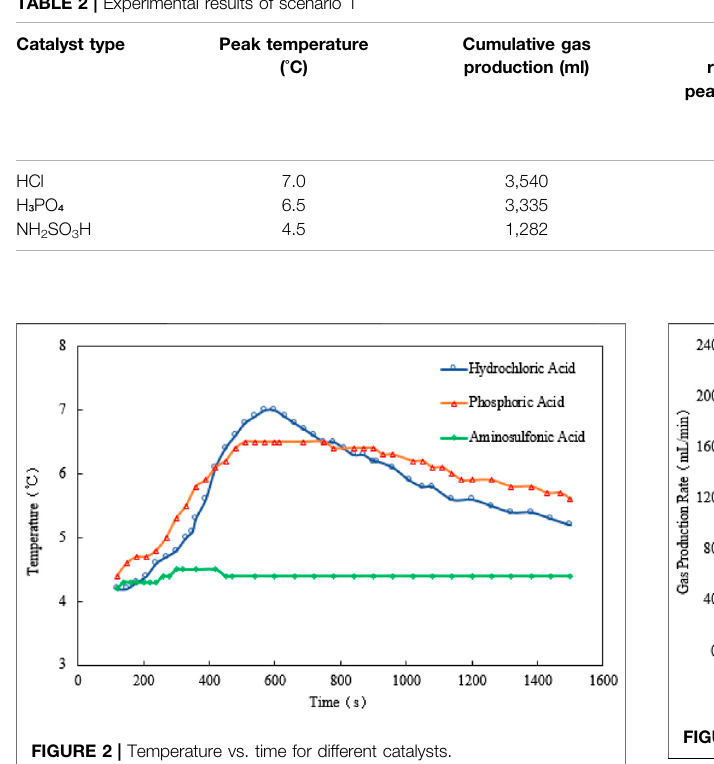
FIGURE 2 | Temperature vs. time for different catalysts.